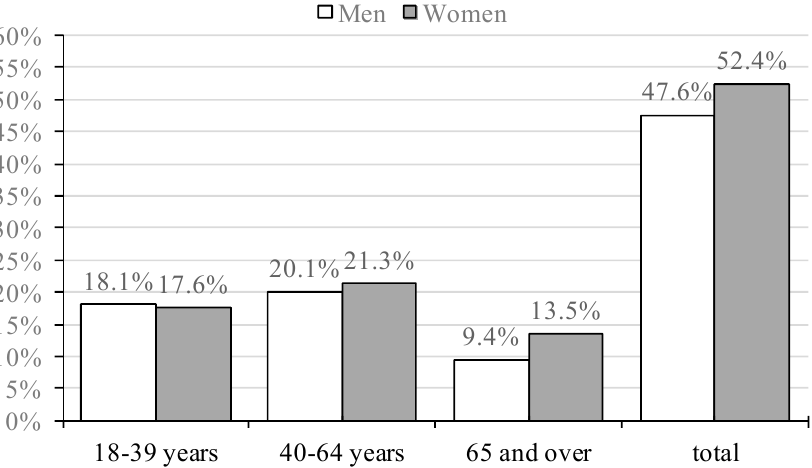
Figure 2. Distribution by sex and age of the respondents. Source: Own elaboration based on FOUM.